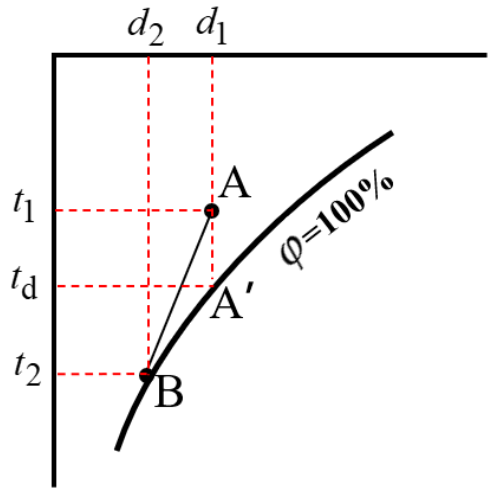
Figure 10. Schematic diagram of the condensation process.